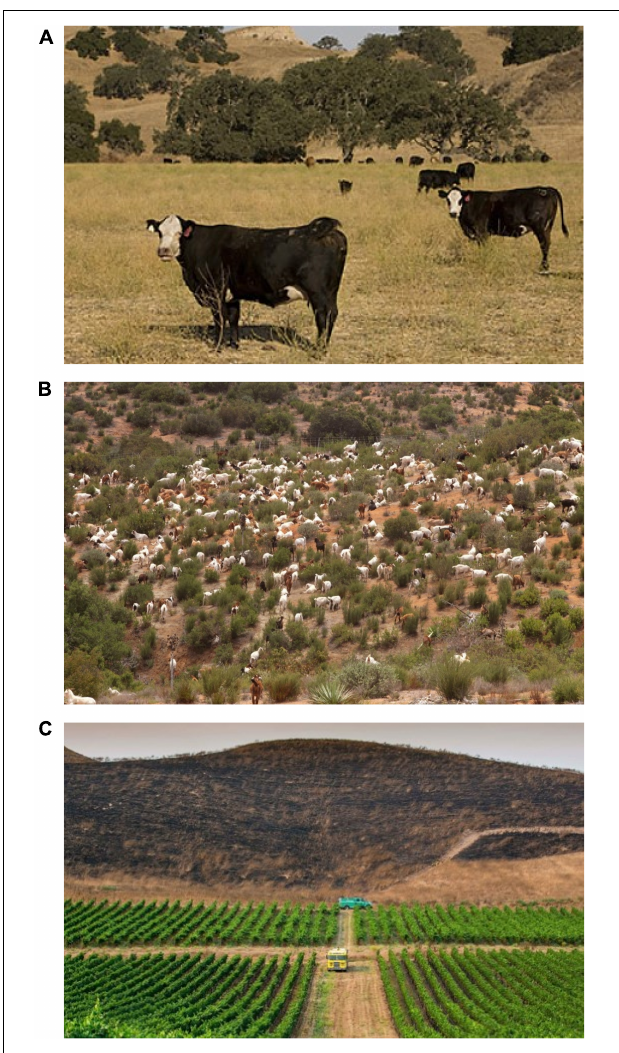
FIGURE 4 | Potential landscape buffers against wildfire. Grazing by cattle (A) or goats (B) can lower fuel loads in open spaces that abut the WUI, increasing the chances for that portion of the landscape to halt or slow fire spread. Orchards (C) can also serve as effective barriers to wildfire in a WUI environment. (Credit: Rob Hazard).